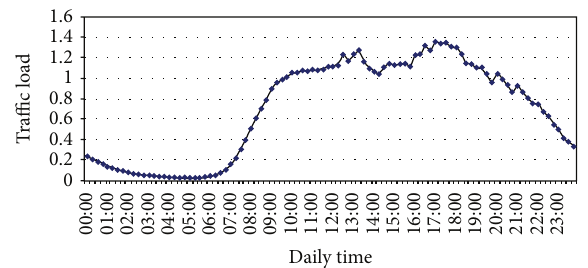
Figure 2: Average traffic distribution over a day for urban environ- ment [29].